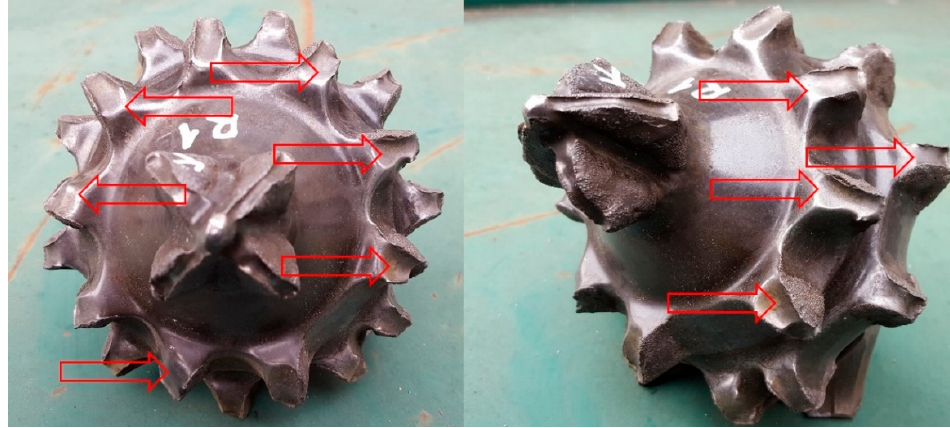
Figure 10. Characteristic wear of the teeth of the roller cone bit.